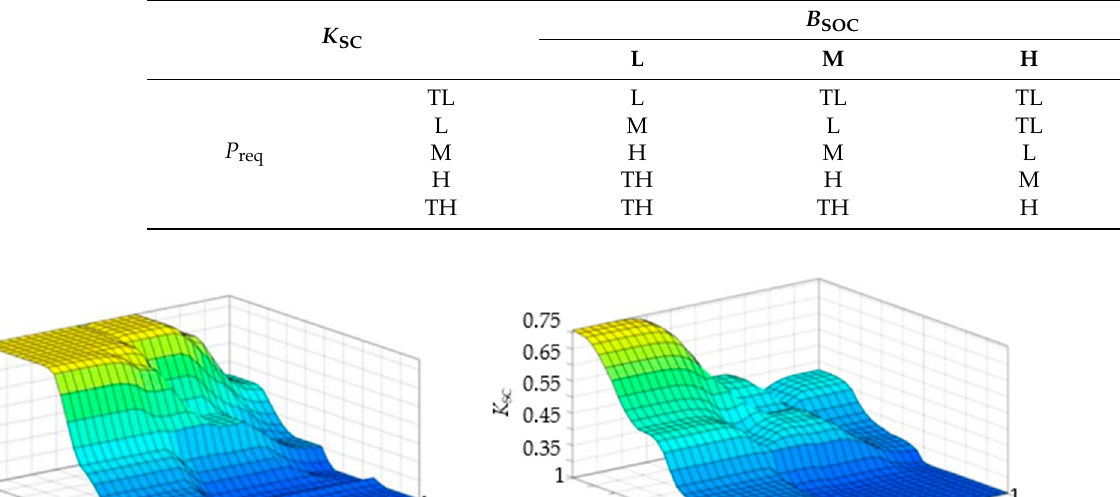
Table 5. Fuzzy control rules ( S SOC = H).